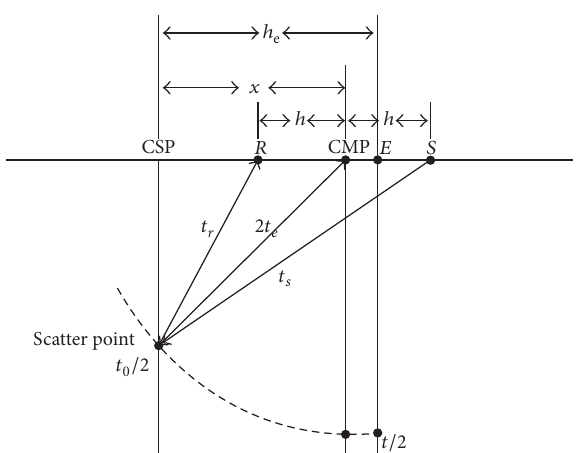
Figure 1: The sketch map to illustrate the geometrical concept of the equivalent offset ( ℎ ). 𝑆 is the source position, 𝑅 is the receiver e position, and 𝐸 is the assumed collocated source/receiver